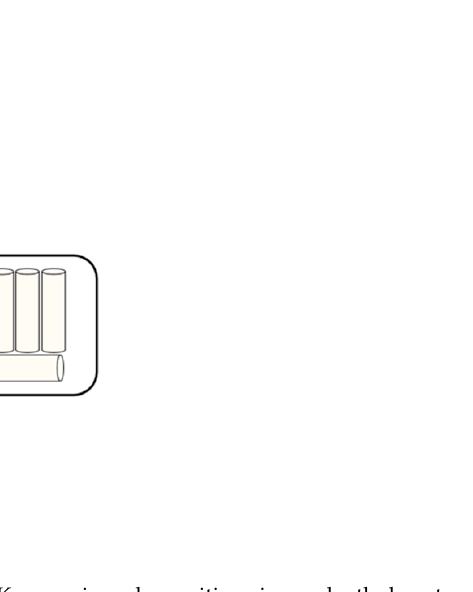
Figure 2. ( A ) Schematic representation of Korean rice cake positions in a polyethylene terephthalate (PET) container and ( B ) the cakes packaged in PET containers in different numbers (4, 8, and 12).